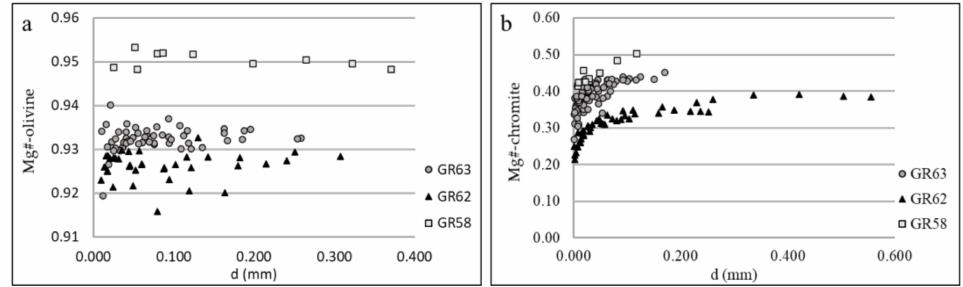
Figure 9. Mg# vs. distance from the grain boundary (mm) of ( a ) olivines and ( b ) chromites in banded and nodular chromitites at Nea